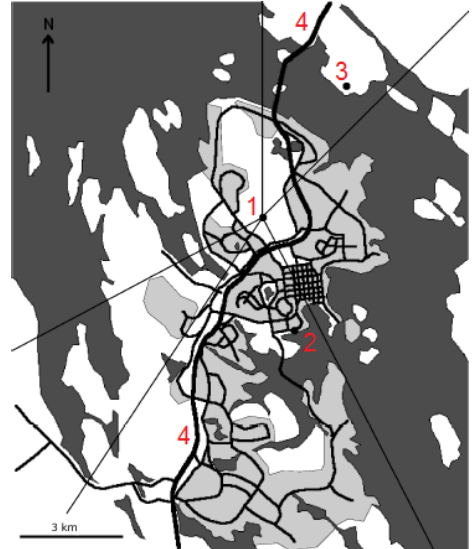
Figure 1. Map of measurement site (adapted from Portin et al., 2014). The dark-gray areas are lakes, the light-gray areas residential areas, and the white areas forest. (1) Puijo measurement station, (2) heating plant, (3) paper mill and (4) highway. The lines define the sectors for local sources.